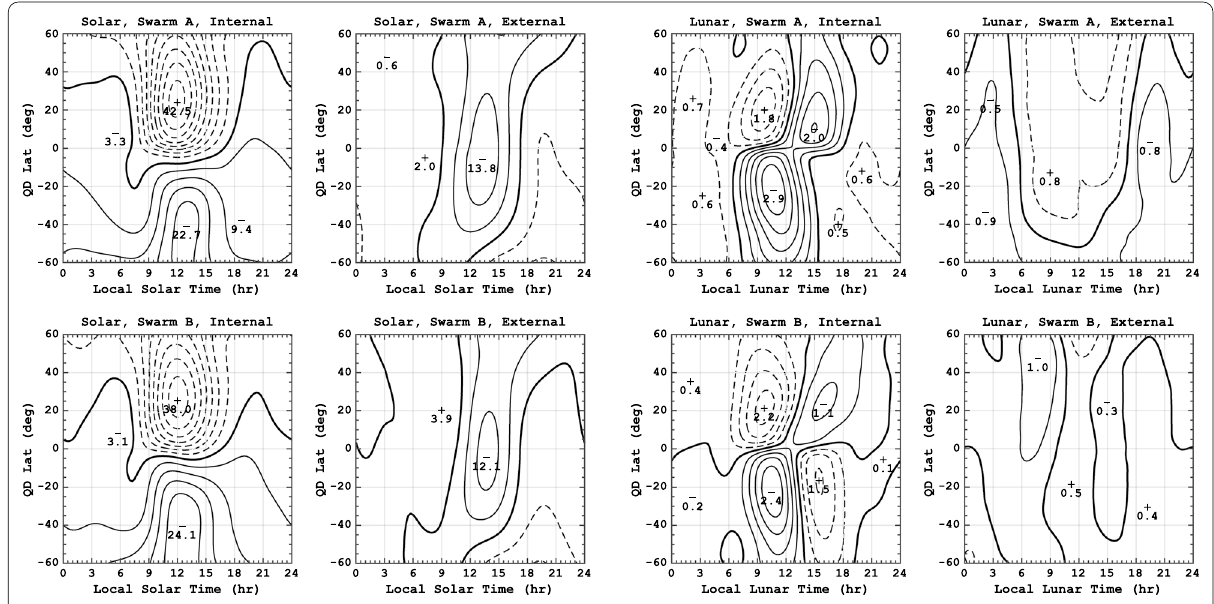
Fig. 5 From left to right, Swam equivalent internal current system for Sq, external current system for Sq, internal current system for L and external current system for L, obtained using quiet-time data during 2017–2020 including all seasons and UTs. Upper and lower panels present the results derived with Swarm A and Swarm B data, respectively. Contour steps are 5 kA for Sq and 0.5 kA for L. It is noted that local lunar time equals local solar time at the new